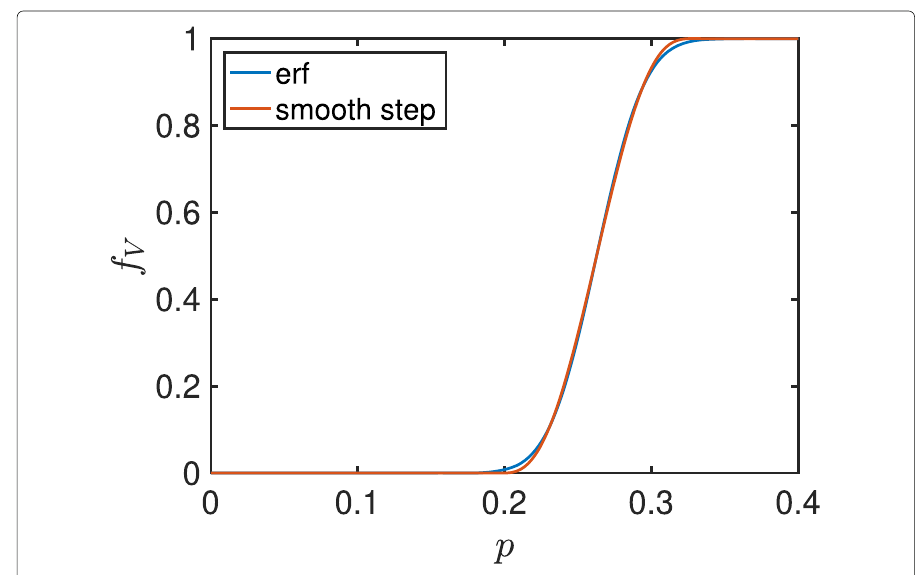
Fig. 10 Comparison of I ( p ) (smooth step function of Eq. 15) and f V (Eq. 13) with parameters based on fit to phase-field